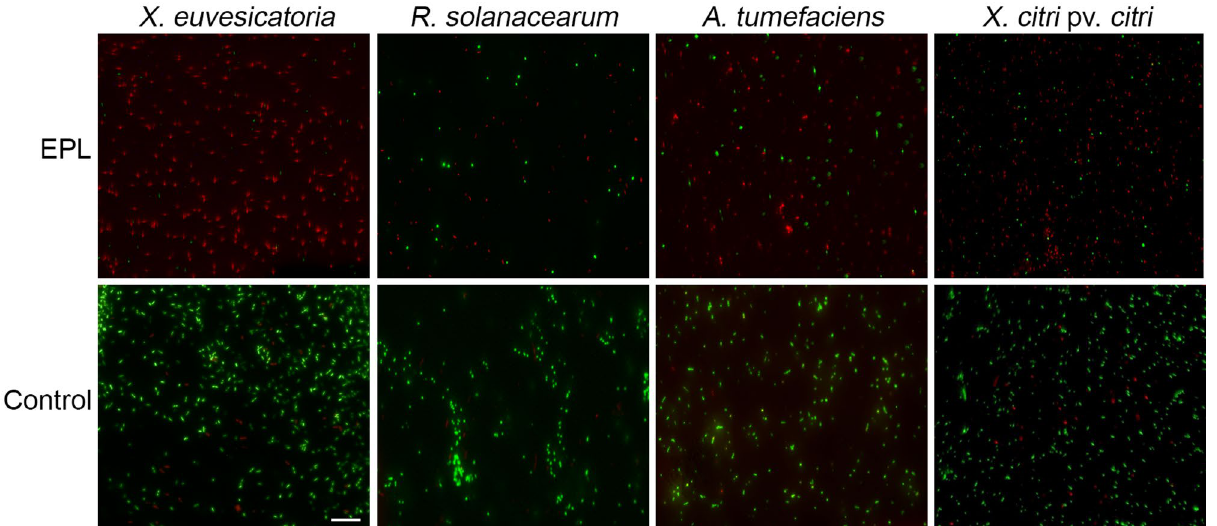
Figure 4. Overlap of fluorescence images of bacterial cells stained with SYTO 9 and propidium iodide for 15 min in the dark. Bacterial cells were treated with EPL at MIC for one hour or water as control. The red fluorescence is emitted because of an interaction between propidium iodide and DNA when the cytoplasmic membrane is damaged, whereas bacteria with intact cell membranes are impermeable to propidium iodide and display green fluorescence. Images shown are representative of three biological replicates. Scale bar = 10